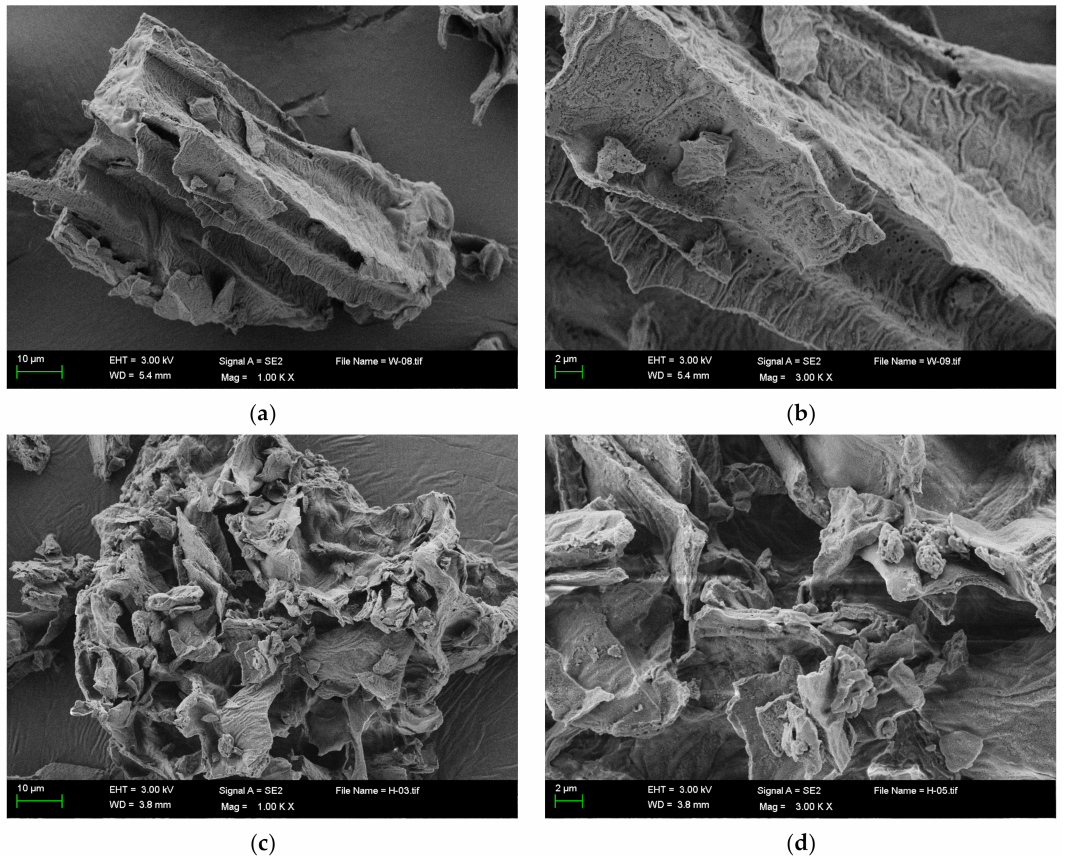
Figure 2. SEM images of UF and MF. ( a ) SEM images of UF × 1000; ( b ) × 3000; ( c ) SEM images of